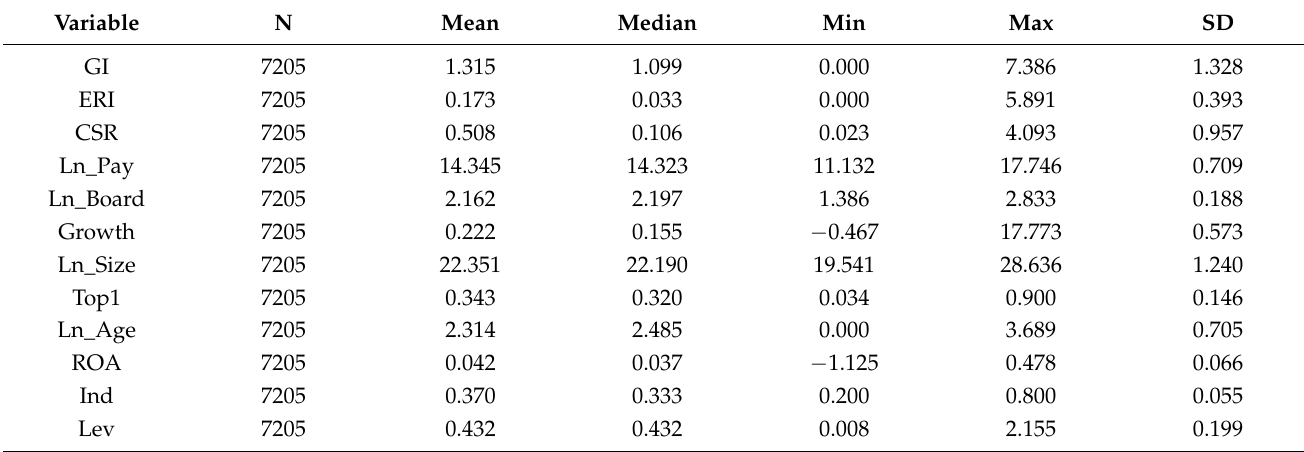
Table 2. Descriptive statistics.